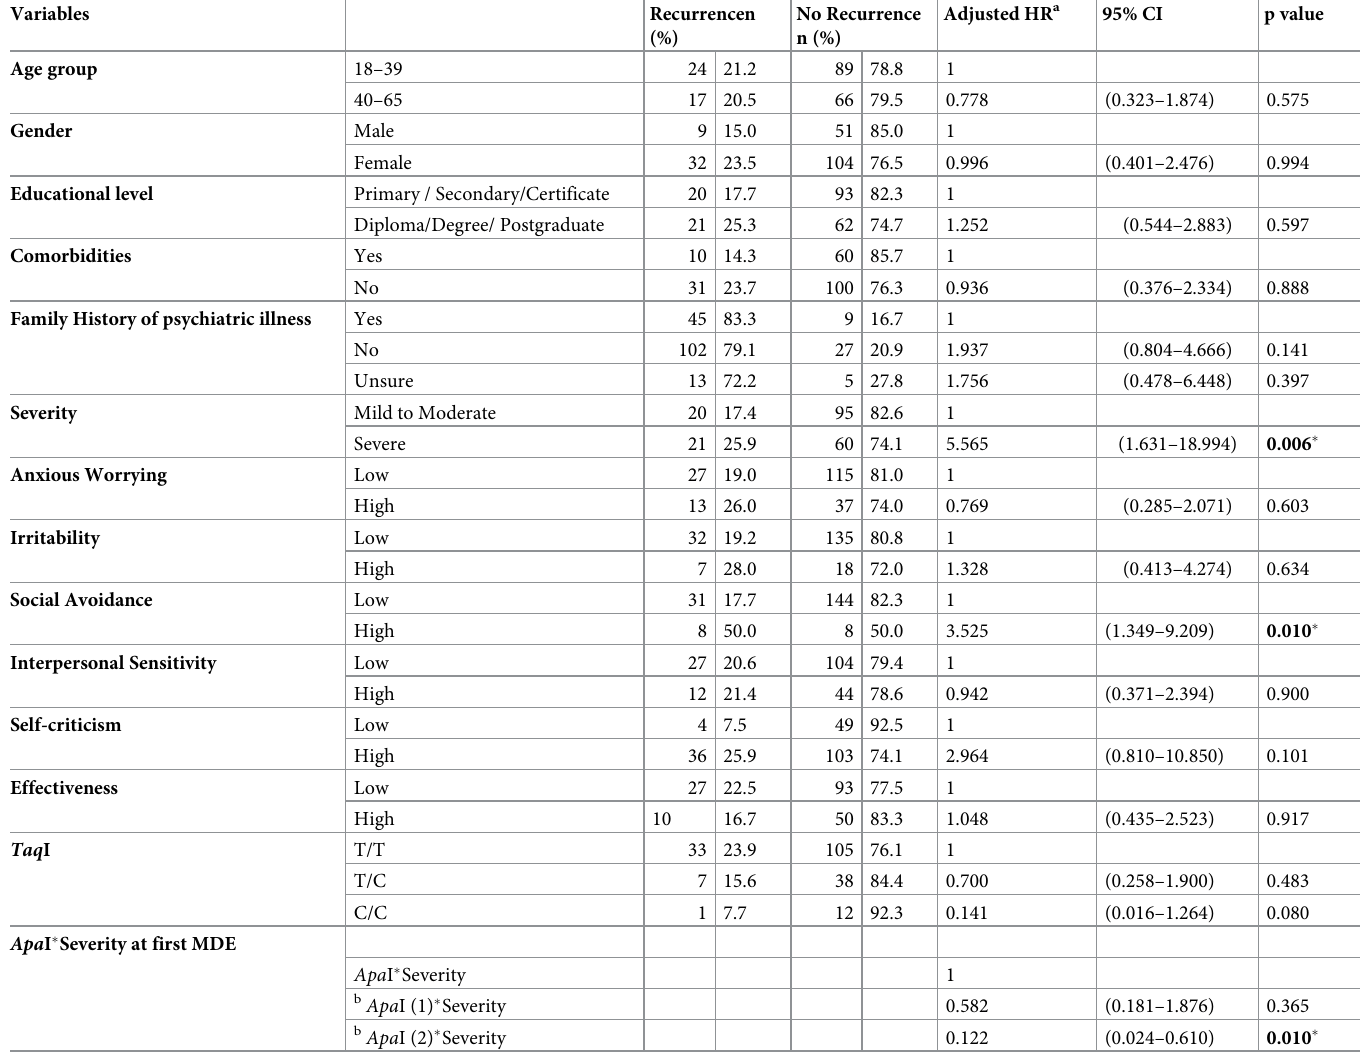
Table 3. Cox proportionate hazard analysis for predictors of MDD recurrence (n =